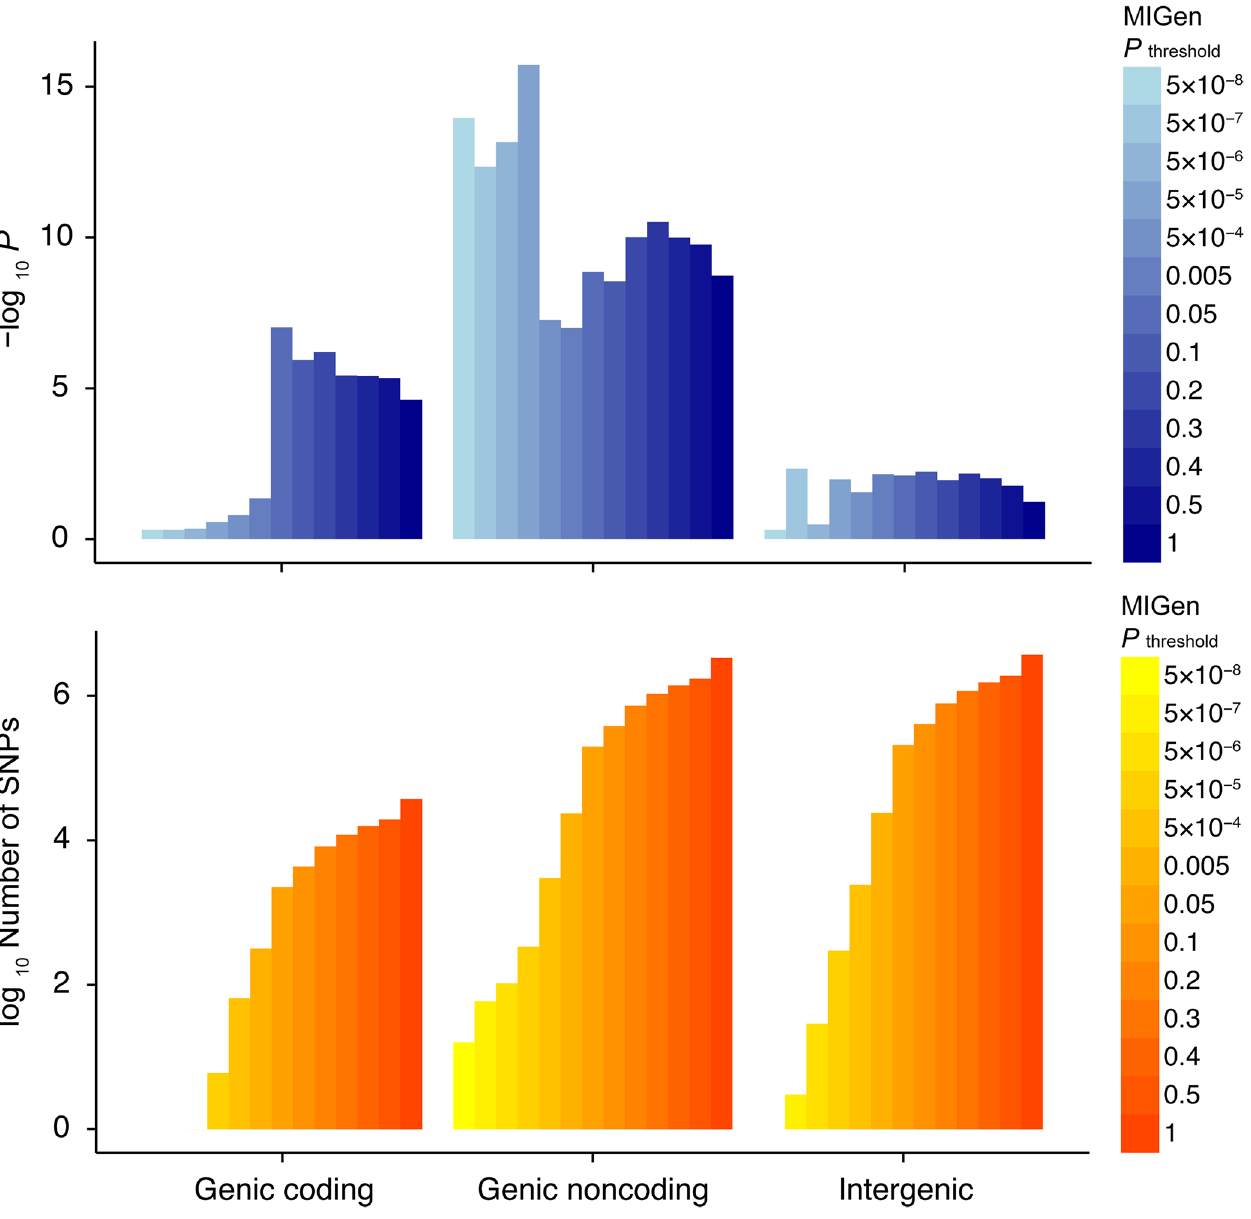
Fig 1. Contributions of three genomic compartments to the polygenicity of MI/CAD. Polygenic risk score analysis was performed across three different genomic compartments. The top bar plot represents the strength of association for the polygenic risk score analysis whereas the bottom bar plot represents the number of SNPs within each of the compartments. The strongest polygenic association signals were within noncoding regions adjacent to protein-coding genes ( “ genic noncoding ” ). MI, myocardial infarction; CAD, coronary artery disease; SNP, single nucleotide polymorphism. Genic coding, variants that code amino acid sequence within ± 10 kilobases of the 3 0 or 5 0 untranslated regions of a gene. Genic noncoding, variants that do not code amino acid sequence within ± 10 kilobases of the 3 0 or 5 0 untranslated regions of a gene. Intergenic, variants that are beyond ± 10 kilobases of the 3 0 or 5 0 untranslated regions of a